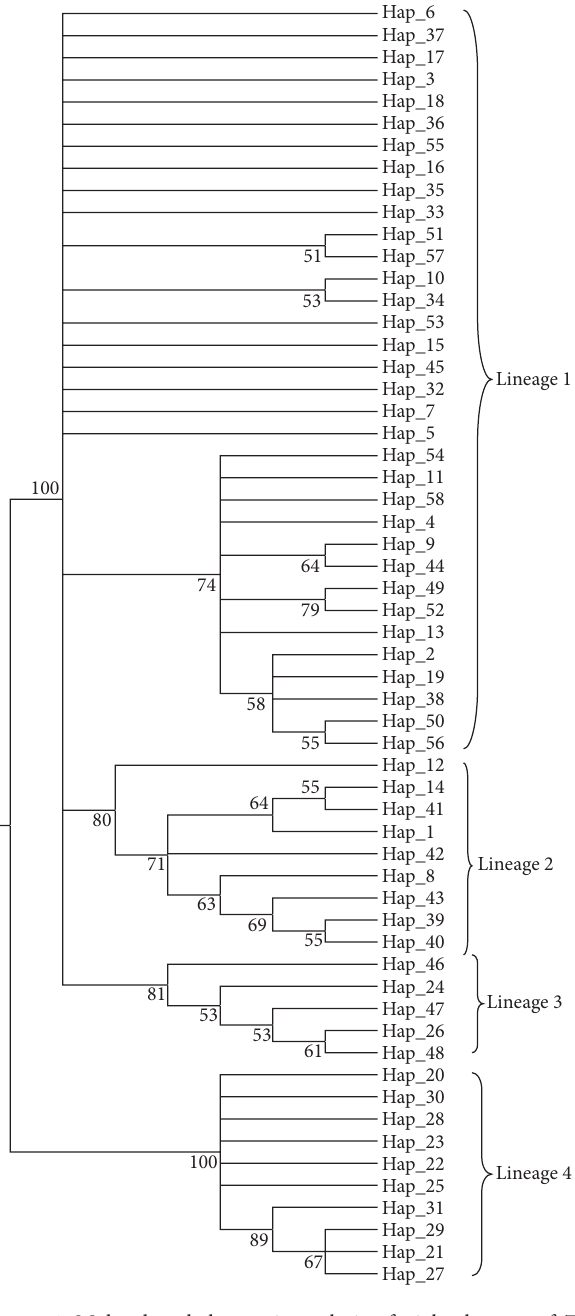
Figure 1: Molecular phylogenetic analysis of 58 haplotypes of